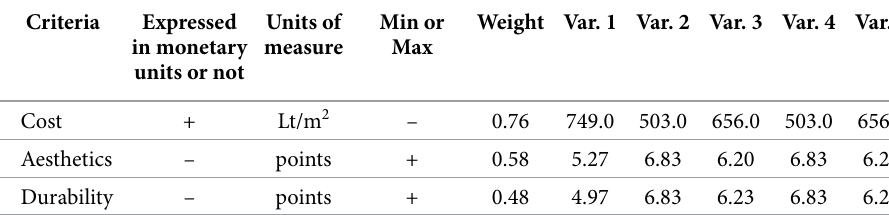
Table 5. Alternatives of multiple criteria evaluation of construction